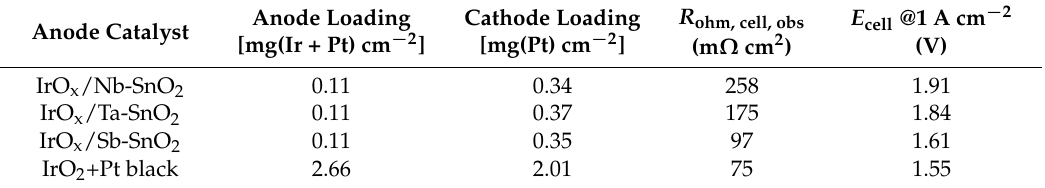
Table 2. Noble metal loadings on CCMs, ohmic resistances ( R ohm, cell, obs ) and cell potentials ( E cell ) at 1 A cm − 2 for various cells. Anode Anode Catalyst